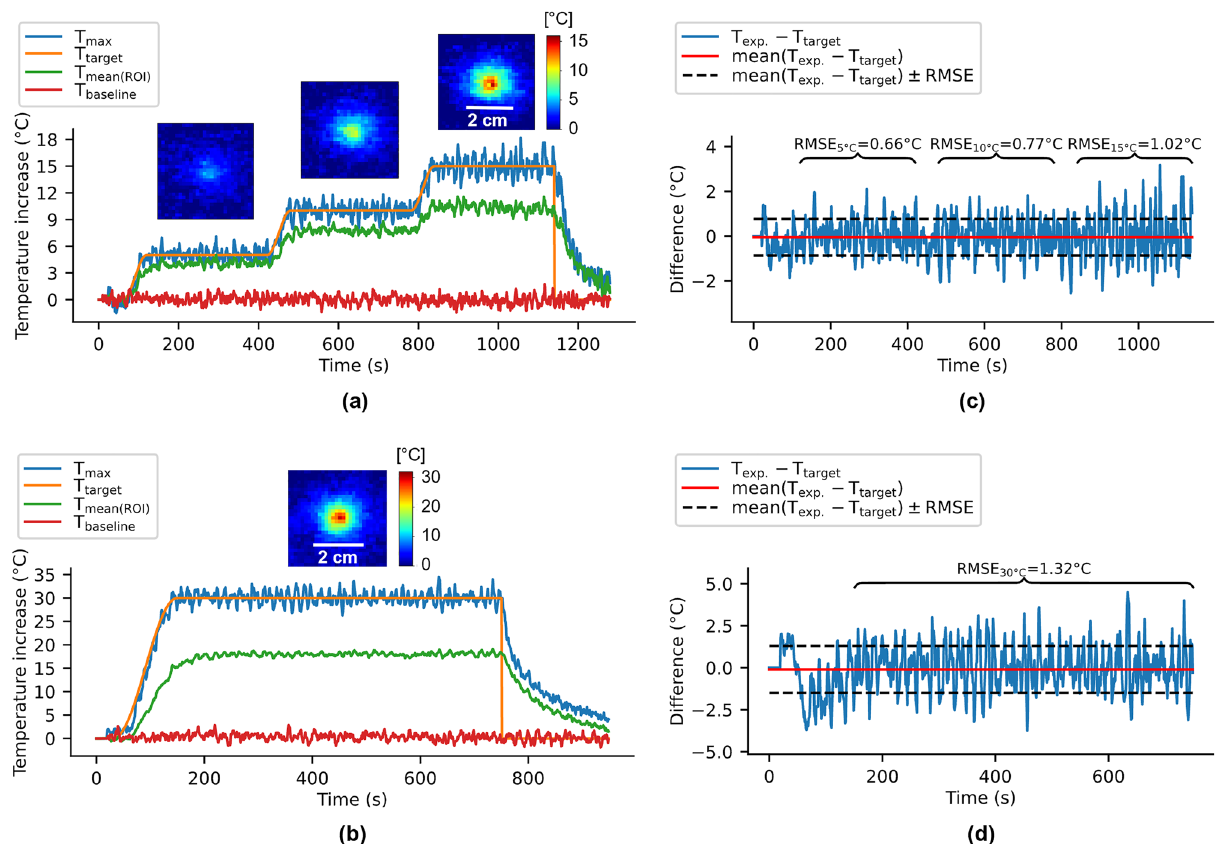
Figure 5. Examples of in vivo automatic temperature regulations during LITT. First column shows examples of automatic temperature regulations in a pig leg muscle, for 2 temperature–time profiles showing 3 successive plateaus (5 °C, 10 °C and 15 °C—300 s duration each) ( a ) and one unique plateau of 30 °C for 700 s ( b ). Target profile (orange), maximal (blue), and mean (green) temperature curves over the 3 displayed. The red curve shows temperature evolution in a non-heated single voxel. Image insets: temperature maps obtained in the middle of each temperature plateau (same color scale for each example). Graphs ( c ) and ( d ) in the second column show the difference between the experimental temperature and the target temperature, its mean, and its RMSE for example ( a ) and ( b )